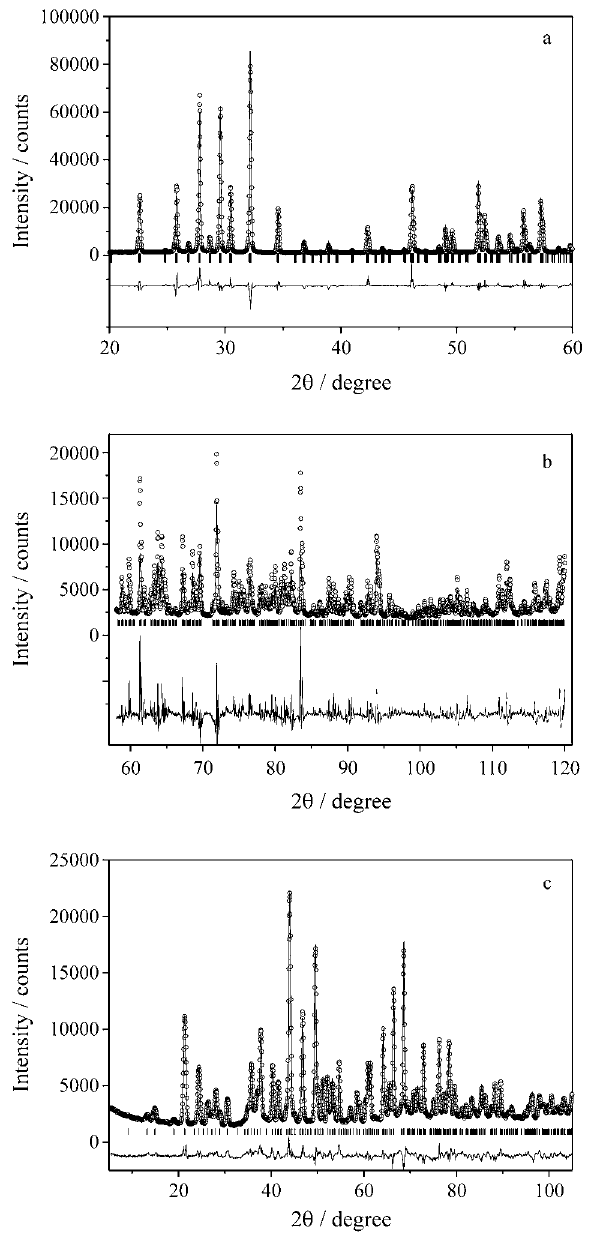
Figure 2. Fitting with GSAS for the three SBN powder patterns: (a) and (b) X-rays CuK α radiation, (c) neutron radiation with λ = 1.4875